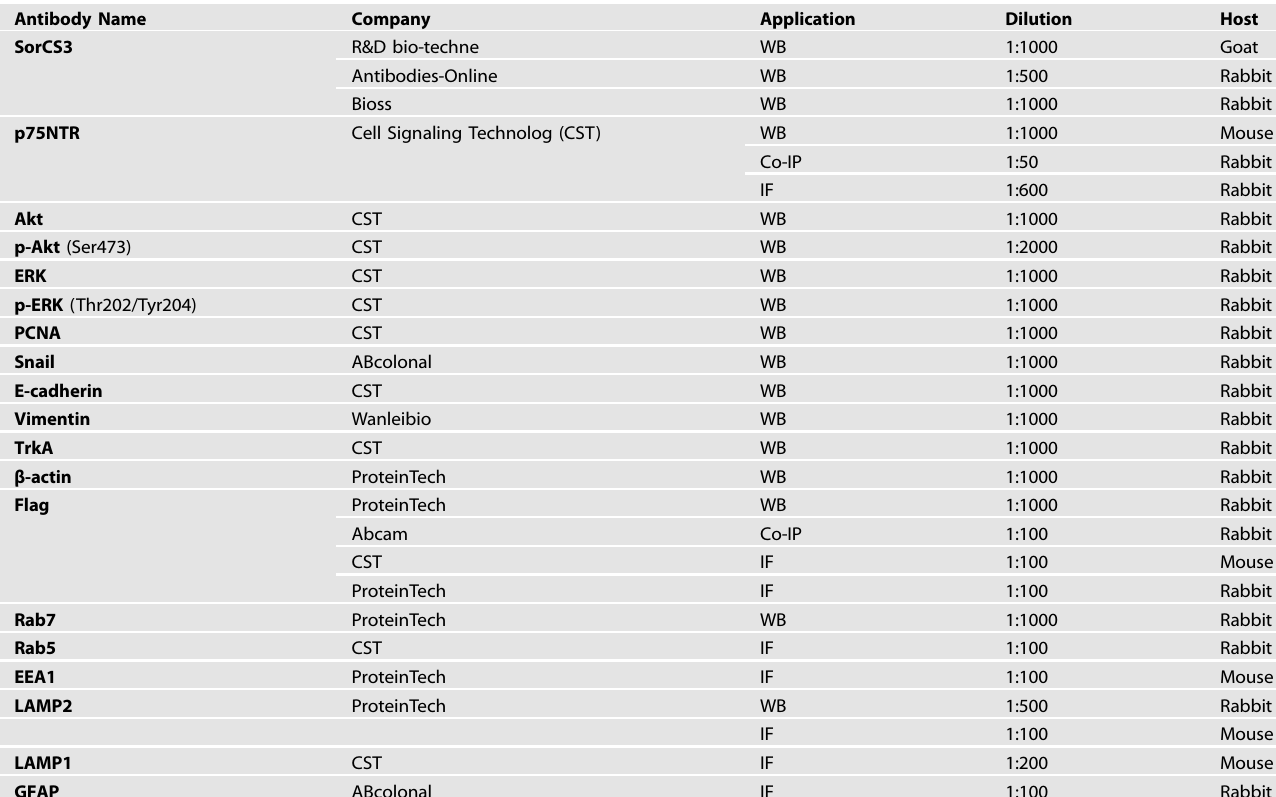
Table 2. Information of antibodies used in this